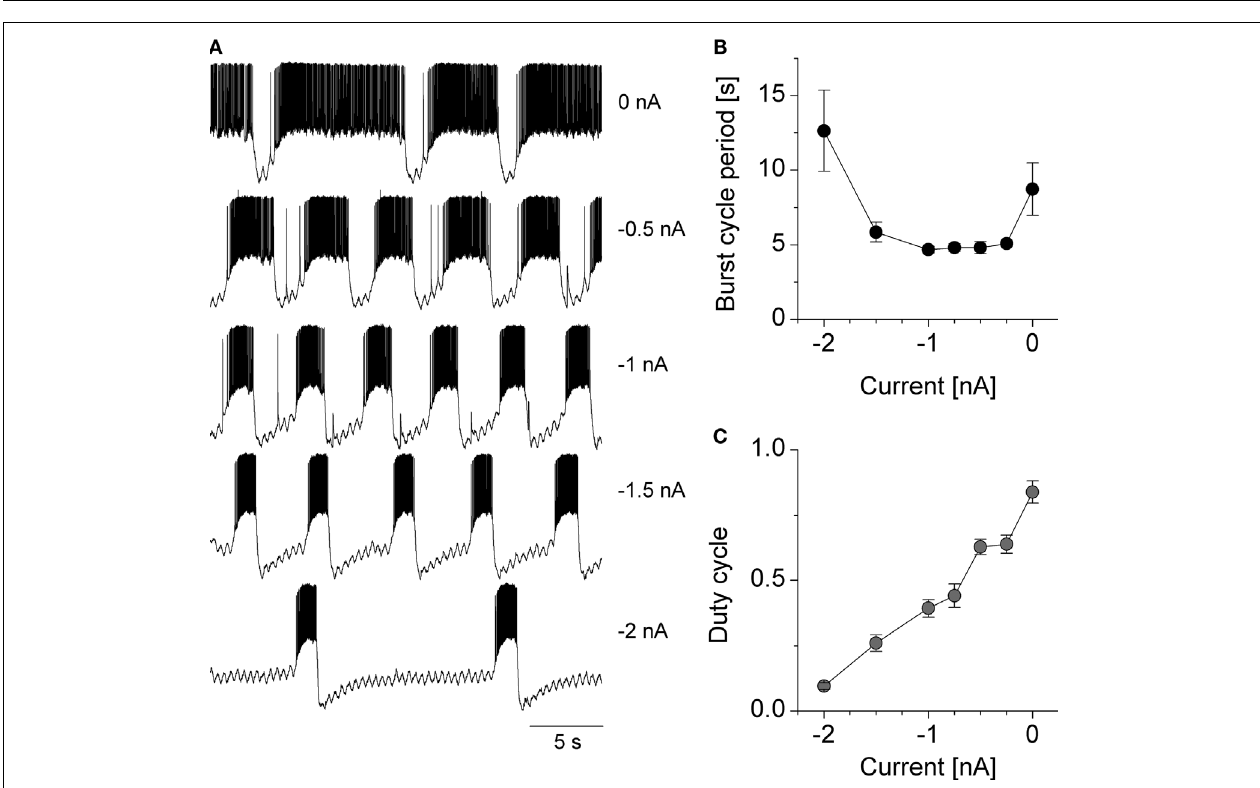
intense (B) . When both types of chemical synapses are blocked, the GM becomes tonic but Int 1 and MG continue bursting. At the same time, MG starts bursting in-phase with Int 1. The LG here is silent but in many cases it too continues bursting in-phase with the Int 1. Note that the fast inhibition from Int 1 to MG is lost and there is a phase advance of its burst. This is due to the remaining excitatory component from Int 1 which is atropine insensitive.